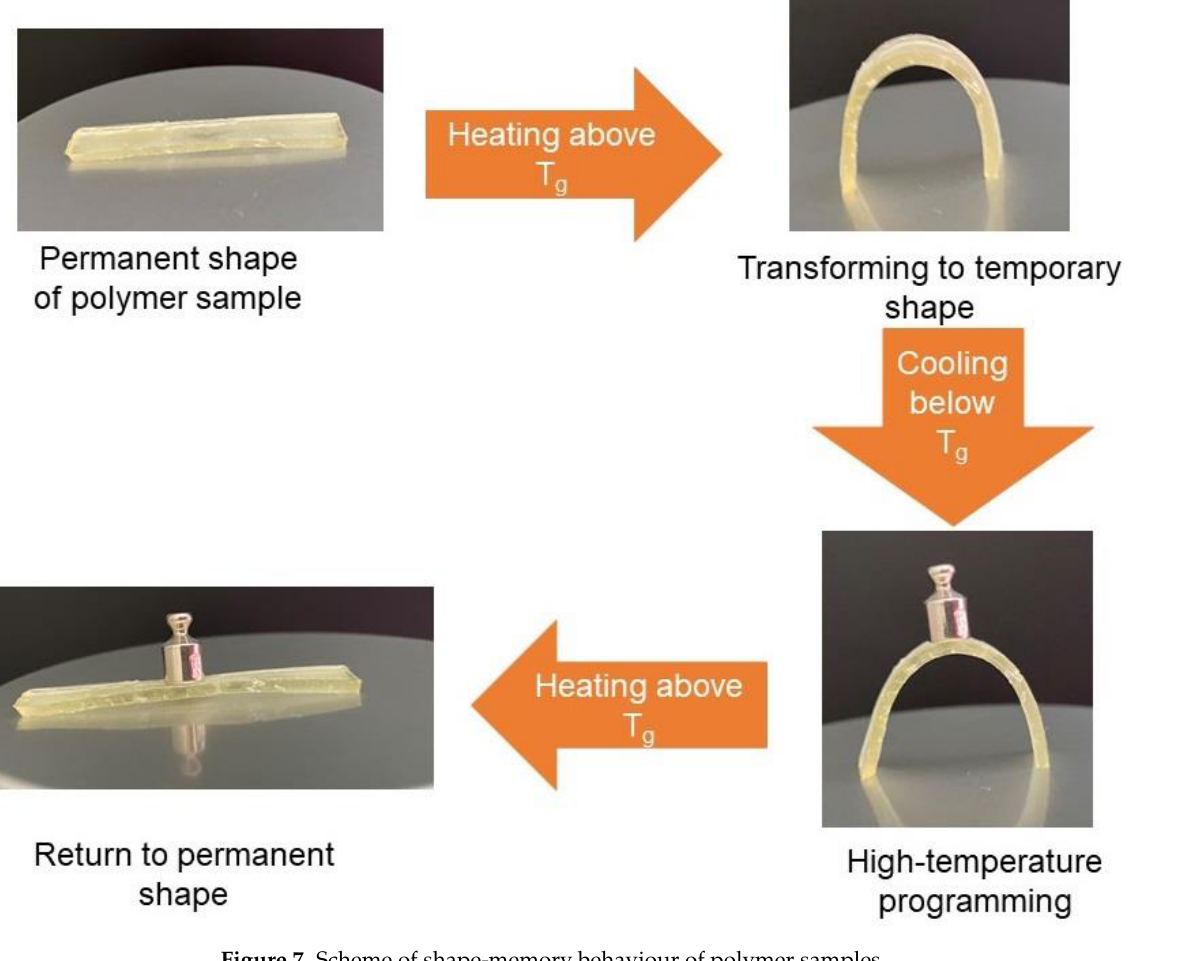
Figure 7. Scheme of shape-memory behaviour of polymer samples.